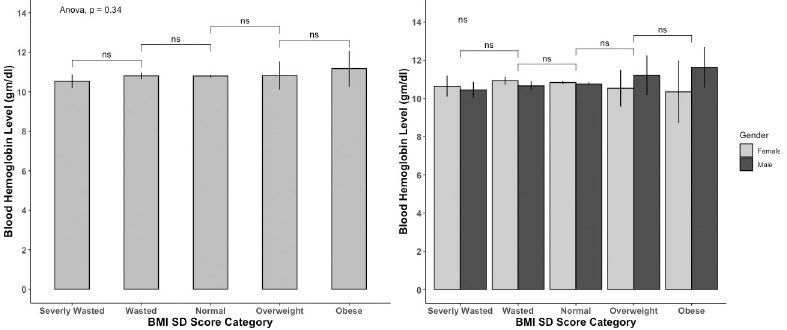
Fig 2. Hemoglobin level of children (n = 2373) according to BMI category and gender.